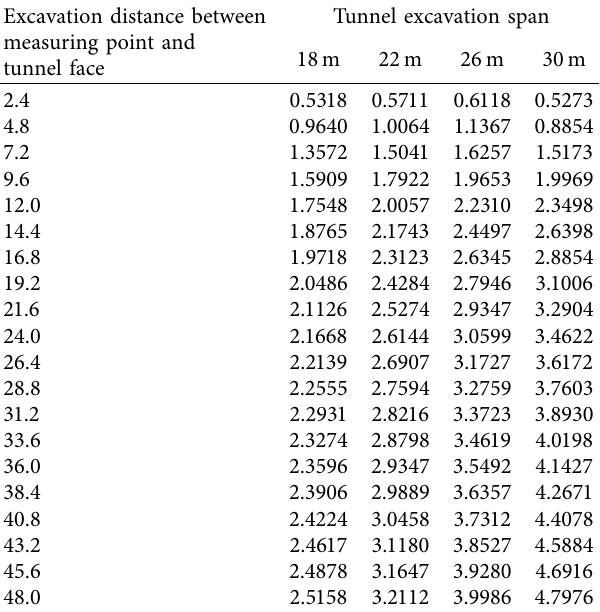
Table 3: Settlement of tunnel vaults with diferent excavation spans (unit: cm).